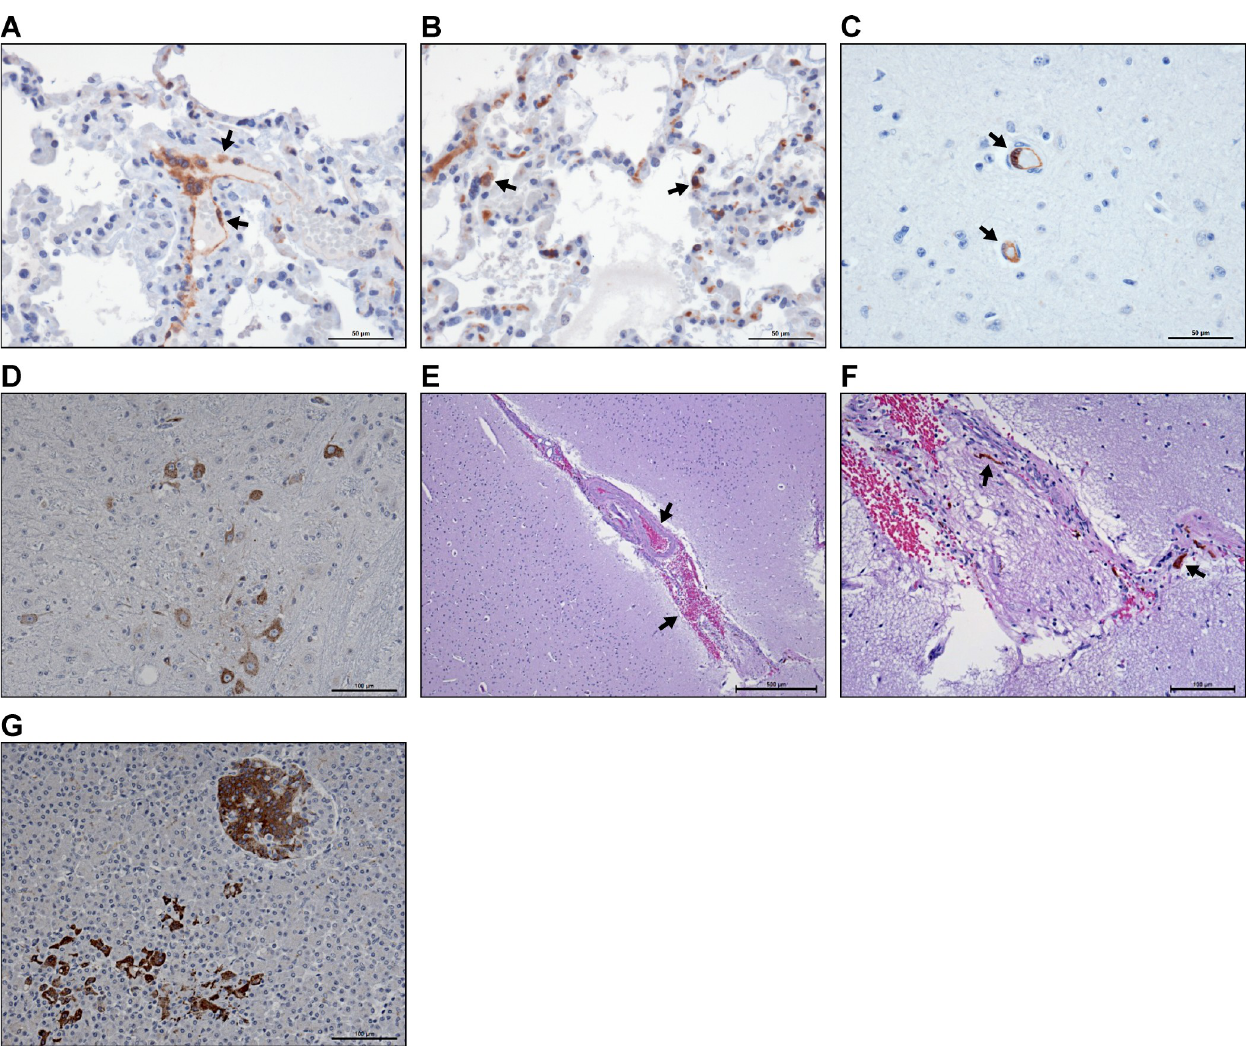
Fig 4. Histopathological assessment of select tissues from AGM following NiV exposure. Immunohistochemical analysis of tissues from NiV infected animals identified viral antigen in several different cell types, but was more prominent in (A) endothelial cells and histiocytes. In the lung, viral antigen was also found in (B) pneumocytes. In the brain, (C) virus was generally found in endothelial cells (C), with antigen found occasionally in neurons (D), but only in foci rather than broadly distributed. Following identification of a lesion in the brain by MRI (see Fig 3C-lower panel), histological assessment of the hyperintense lesion (E and F) identified a microhemorrhage with hemosiderin laden macrophages apparent, but no evidence of viral antigen. Viral antigen was also identified in the pancreas where degeneration of the islets was evident (G). Arrows in (A and (C) indicate viral antigen in endothelial cells. Arrows in B indicate viral antigen in pneumocytes. Arrows in (E) indicate areas of hemorrhage. Arrows in (F) indicate hemosiderin laden macrophages. Scale bars for panels (A-C) are 50 μ m, for panels (D) (F) and (G) are 100 μ m; for panel (D) is; and for panel (E) is 500 μ